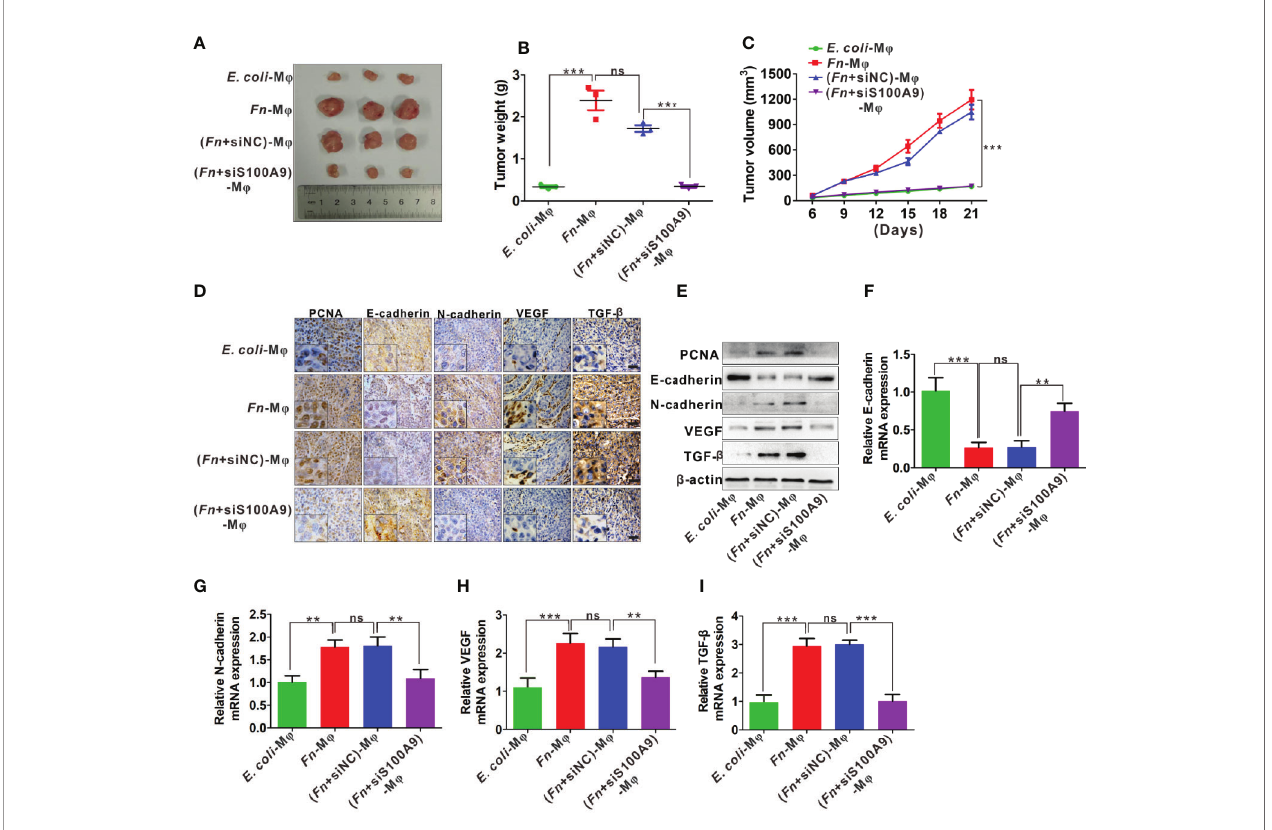
FIGURE 6 | Fn -caused M2 polarization mediated by S100A9 promotes the growth of subcutaneous tumor. (A) Representative images of tumors in mice co-injected with equal amount of HCT116 cells and control E. coli -treated, Fn -treated, ( Fn + siNC)-treated or ( Fn + siS100A9)-treated M j . (B) Images of tumor weights in different groups, n = 3/group. (C) Statistical analysis of tumor volumes in different groups, n = 3/group. (D) Representative immunohistochemistry images of PCNA, E-cadherin, N-cadherin, VEGF, and TFG- b proteins in representative xenograft tumor sections. Scale bars: 50 µm. (E) Western blot analysis of PCNA, E-cadherin, N-cadherin, VEGF, and TFG- b protein levels in representative xenograft tumor. (F – I) qPCR analysis of E-cadherin, N-cadherin, VEGF, and TGF- b expression in each xenograft tumor, n = 3/group. Data were expressed as means ± SD in three independent experiments. ns, not signi fi cant. **p < 0.01, ***p <